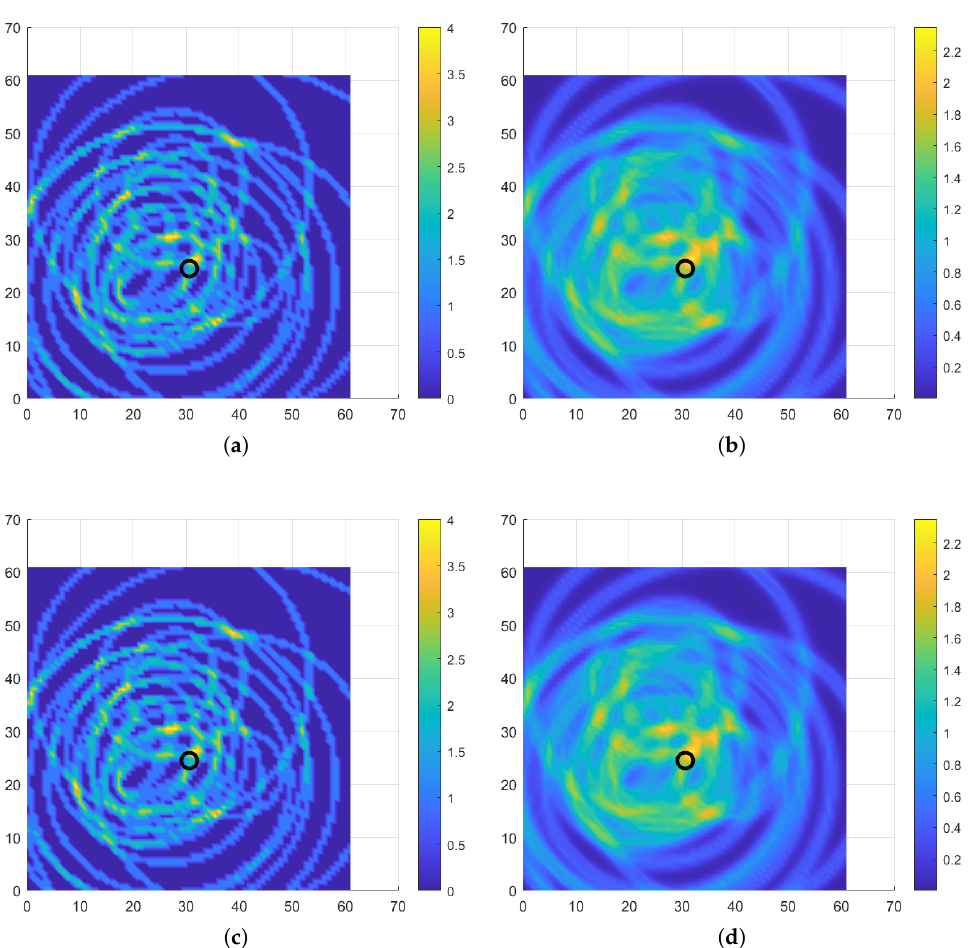
Figure 11. Damage maps comparing the two cost functions ( a ) Number of ellipses for D2 ( b ) Expo- nential function for D2 ( c ) Number of ellipses for D3 ( d ) Exponential function for